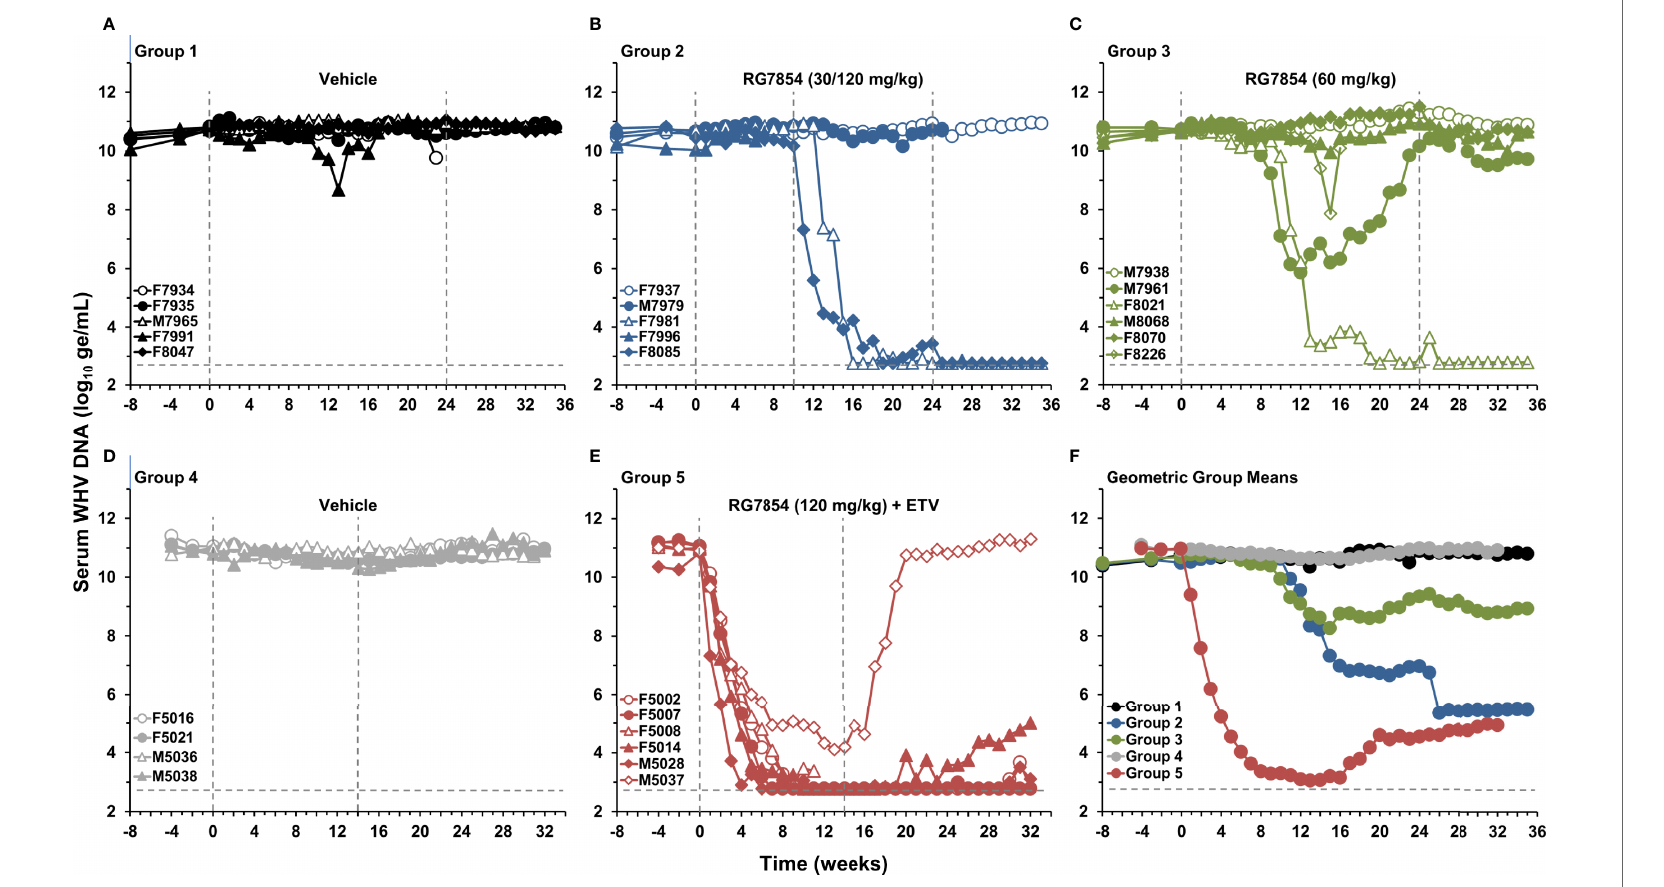
FIGURE 2 | Effect of RG7854, alone and together with ETV, on serum viremia levels. Kinetics of WHV DNA load in individual woodchucks administered (A) placebo or RG7854 at doses of (B) 30/120 mg/kg or (C) 60 mg/kg in the monotreatment study and (D) placebo or (E) RG7854 at a dose of 120 mg/kg plus ETV in the combination treatment study. (F) Geometric group mean WHV DNA loads. The outer vertical dotted lines represent the duration of 24-week monotreatment or 14-week combination treatment, while the inner vertical dotted line represents the switch from 30 to 120 mg/kg RG7854 in Group 2 during week 10 in this and the following fi gures. The horizontal dotted lines indicate the detection limit for WHV DNA by quantitative polymerase chain reaction (i.e., 600 ge/mL). The geometric mean WHV DNA load in Group 3 was signi fi cantly reduced compared to Group 1 at T0 and at week 7 ( P < 0.05) (Student ’ s t -test). Compared to Group 1, the geometric mean WHV DNA load in Group 2 was not signi fi cantly different ( P > 0.05). The geometric mean WHV DNA load in Group 5 was signi fi cantly reduced compared to Group 4 during weeks 1-32 ( P < 0.05). ge, genome equivalents or copy